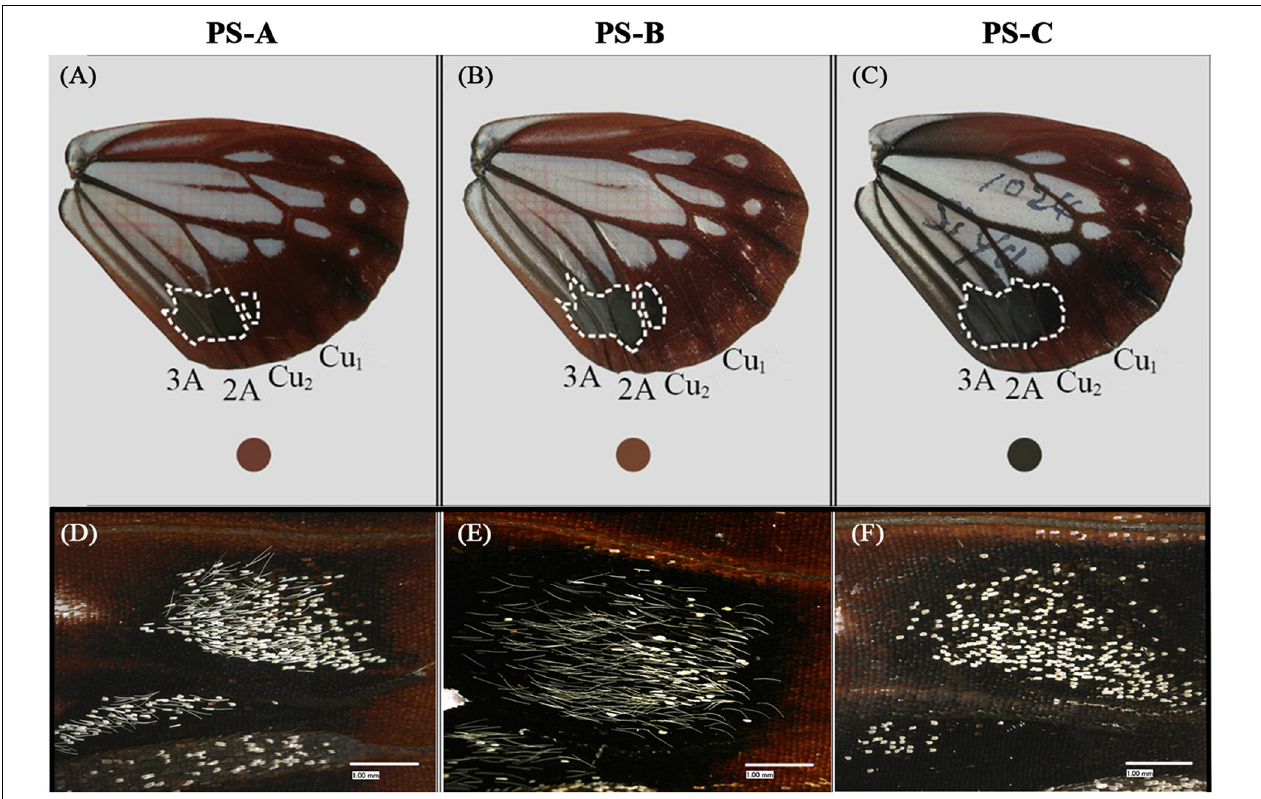
FIGURE 3 | The uppersides (A–C) and undersides (D–F) of representative hindwings of the three Parantica sita lineages: PS-A, PS-B, and PS-C. (A–C) The dotted line surrounds the range of the black patch of the male sex brand, and the color within the colored circle indicates the color near the anal angle of the hindwing. (D–F) Male sex brand variability as shown by modified white scales on the undersides of the sex brands. Scale bar is 1